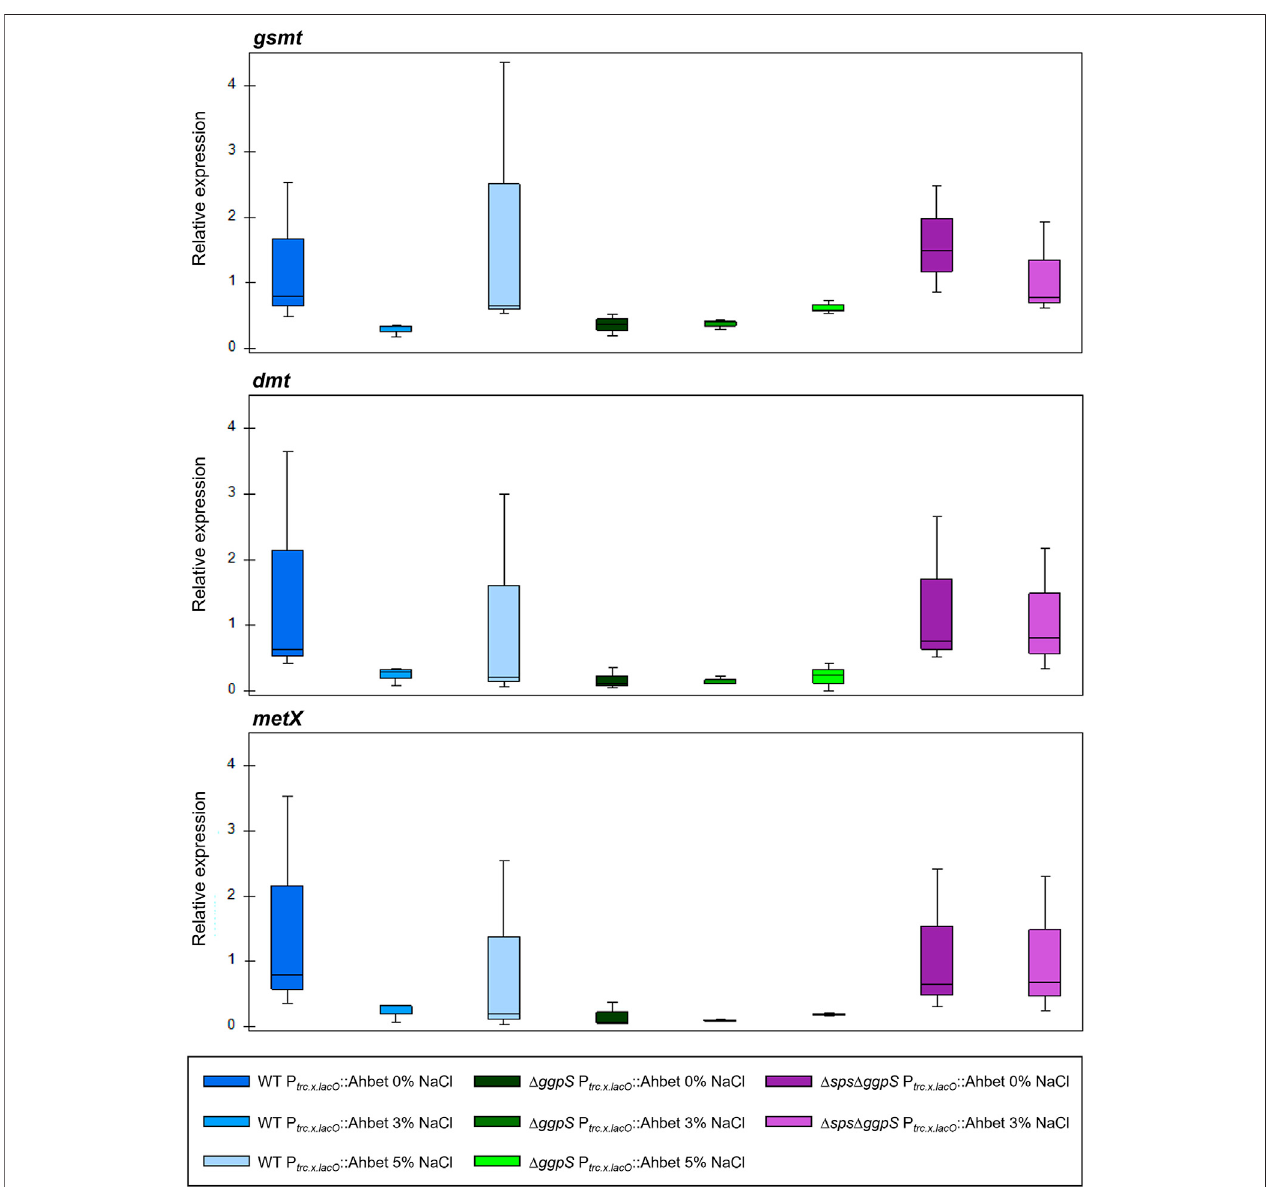
FIGURE 7 | RT-qPCR analysis of gsmt , dmt , and metX relative expression in Synechocystis strains (WT, Δ ggpS , and Δ sps Δ ggpS ) harboring the GB device. RNA wasextractedfromcellsgrowninBG11orBG11supplementedwith3and5%(wt/vol)NaCl,at30 ° Cwithorbitalshaking(150 rpm)undera12 hlight(25 μ E/m 2 /s)/12 h dark regimen. Thebox-whisker plotsrepresent theexpression ofthetargetgenesrelativetoWTP trc.x.LacO ::Ahbetinabsenceofsalt(0%NaCl).Datawereobtainedfrom threebiologicalreplicatesandthreetechnicalreplicates,andthewhiskersrepresenttheminimumandmaximumnon-outliervaluesinthedataset.One-wayANOVA was performed no signi fi cant differences could be